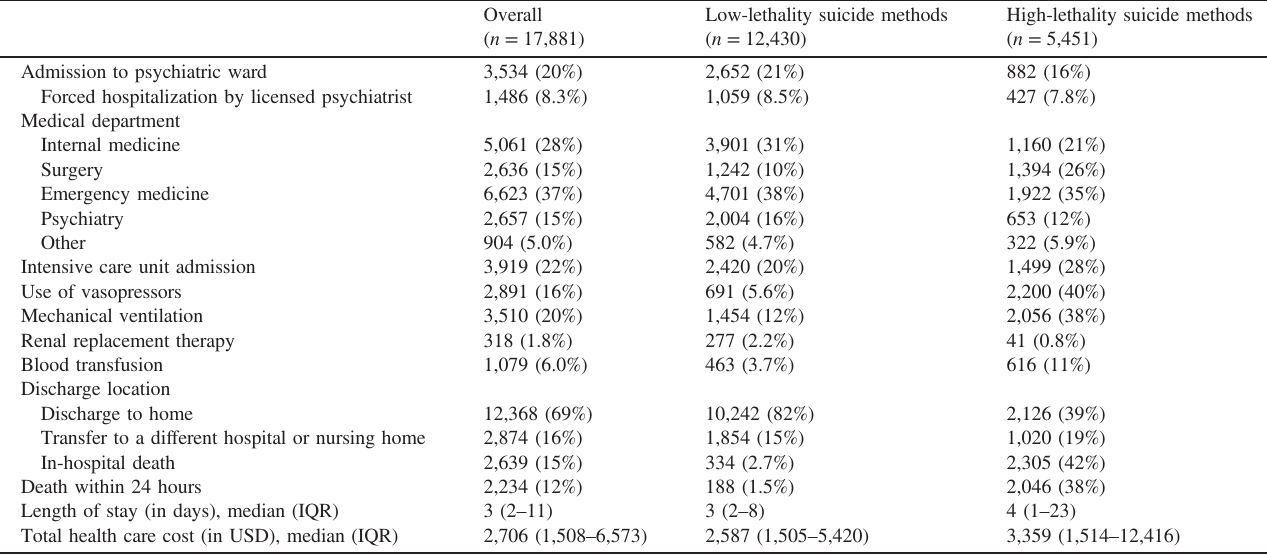
Table 2. Details of clinical practice and discharge status Overall Low-lethality suicide